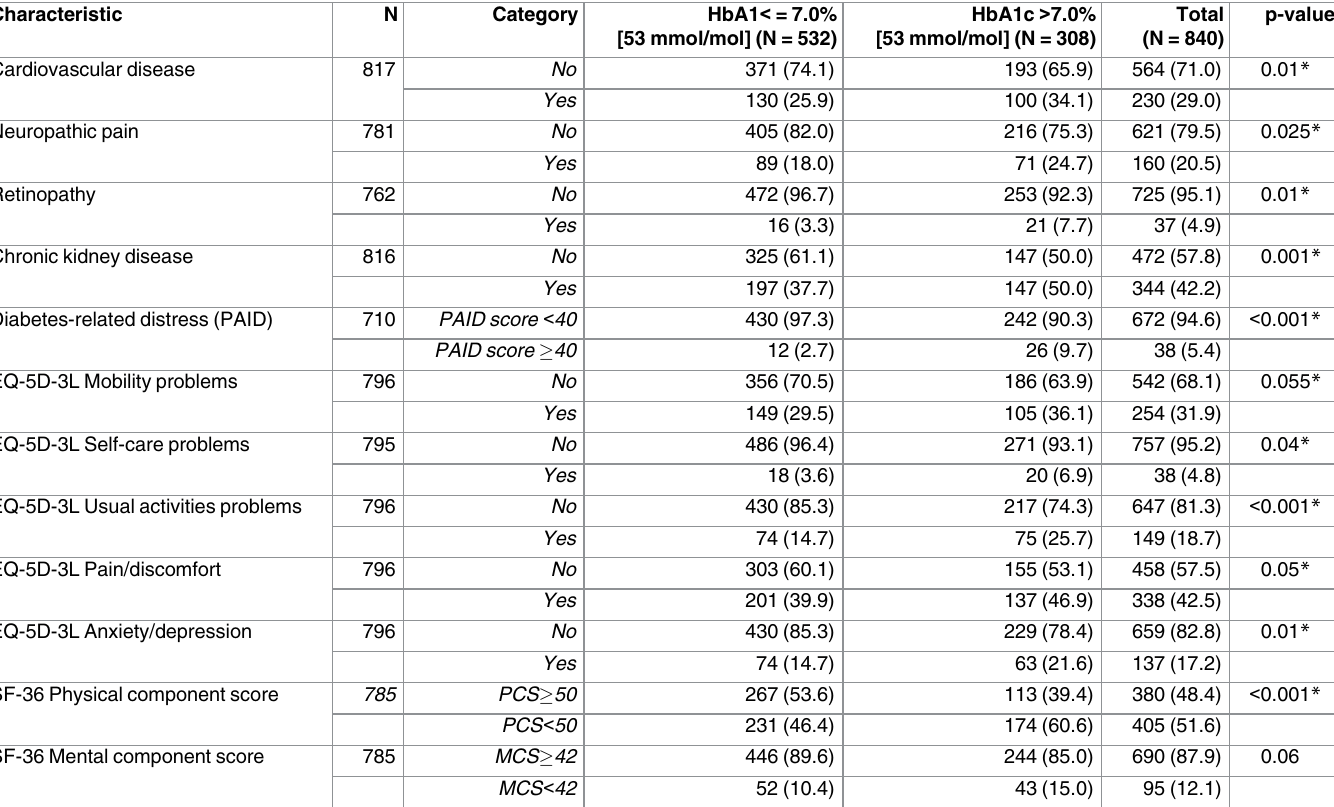
Table 4. Health-related patient characteristics by glycaemic control (binary